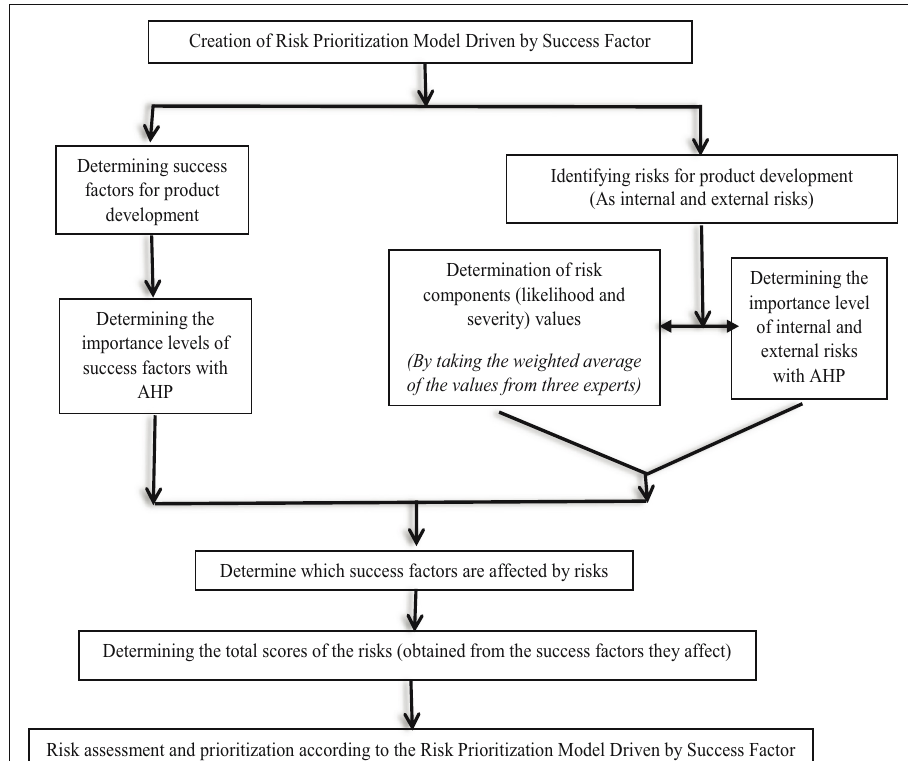
Figure 1: The fl owchart of the